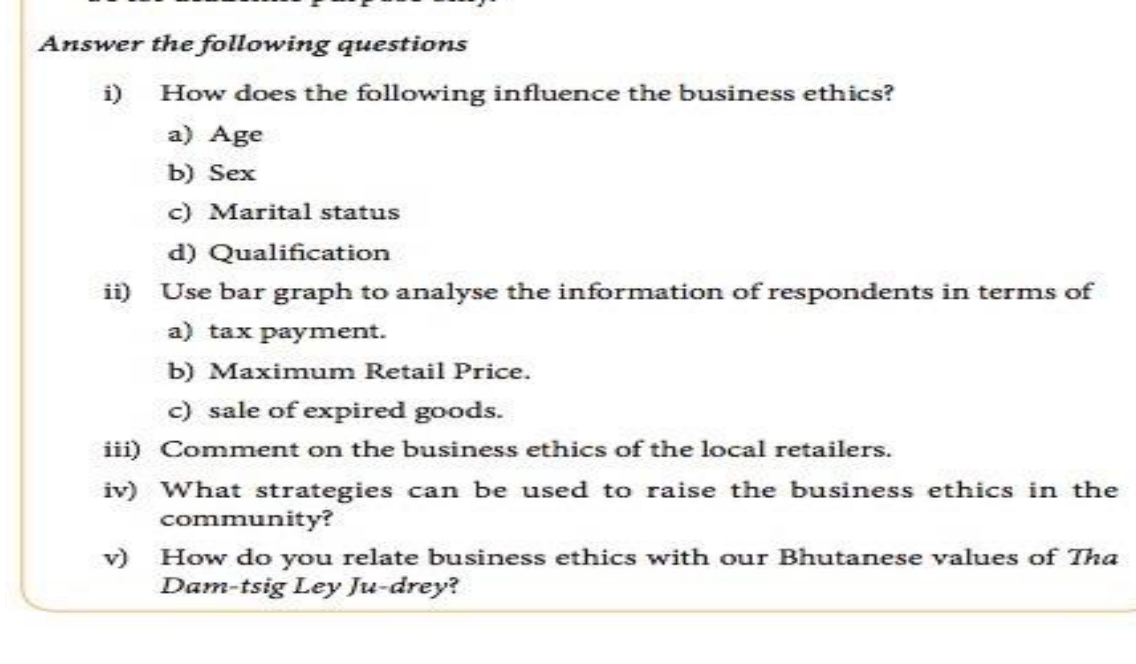
Figure 5: Images of entrepreneurship Source: Economics Class X (REC, 2020, p.